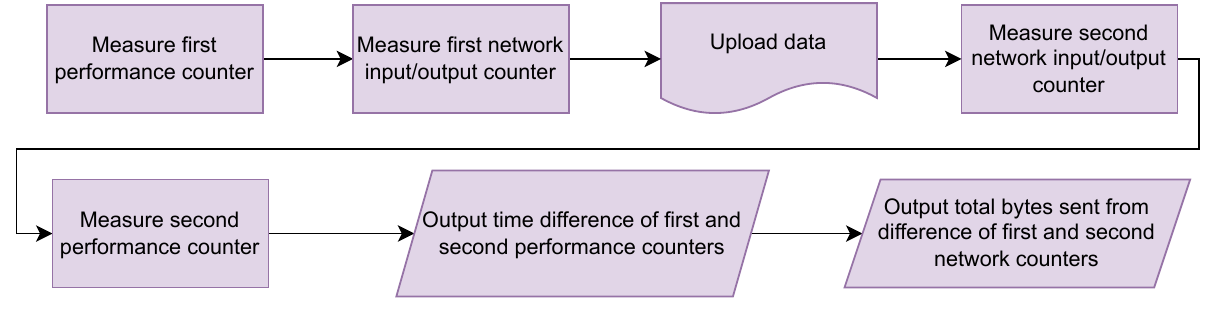
Figure 8. Total bytes uploaded are recorded to determine the bandwidth consumed over the same testing